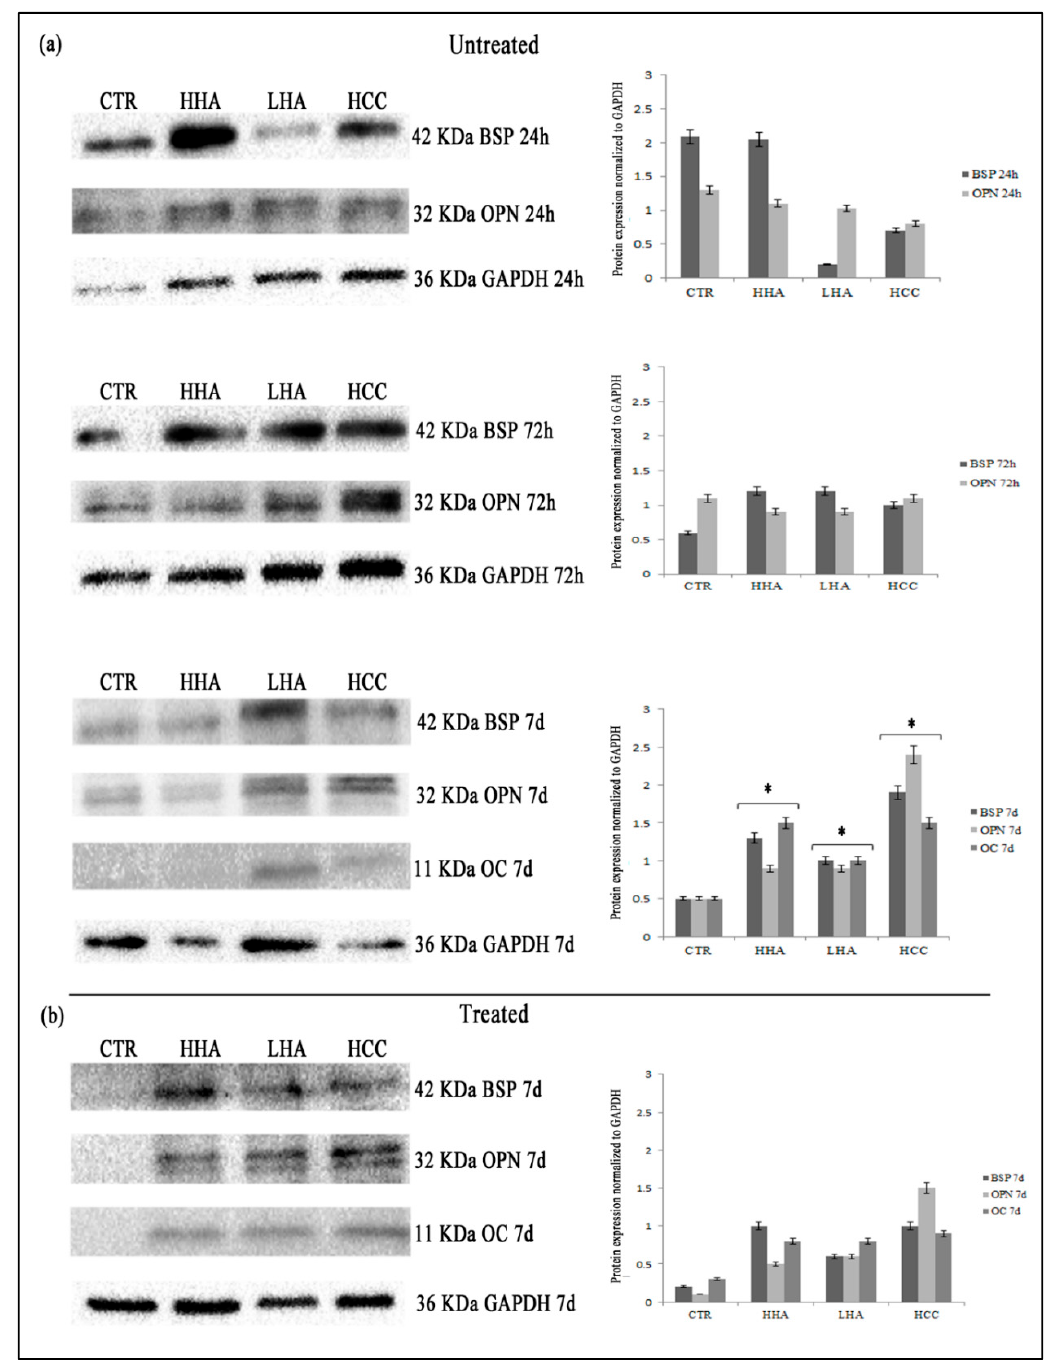
Figure 6. Analysis of OC, OPN and BSP protein expression at 24, 72 h and 7 days by Western blotting in standard medium after YAP/TAZ inhibitor-1 treatment. The expression of OC, OPN and BSP is completely depleted in cells treated with YAP/TAZ inhibitor-1 at 24 and 72 h ( a ). At 7 days only weak signal of protein expression is appreciable ( b ). The results are expressed as the mean ± SD of three independent experiments. * p < 0.01 vs. Untreated. The activation of YAP/TAZ pathway led to the translocation of YAP/TAZ from cyto- plasm in the nucleus. TAZ binds to YAP in cytoplasm and then the complex translocates in the nucleus. In our models, we observed by immunofluorescence that in untreated